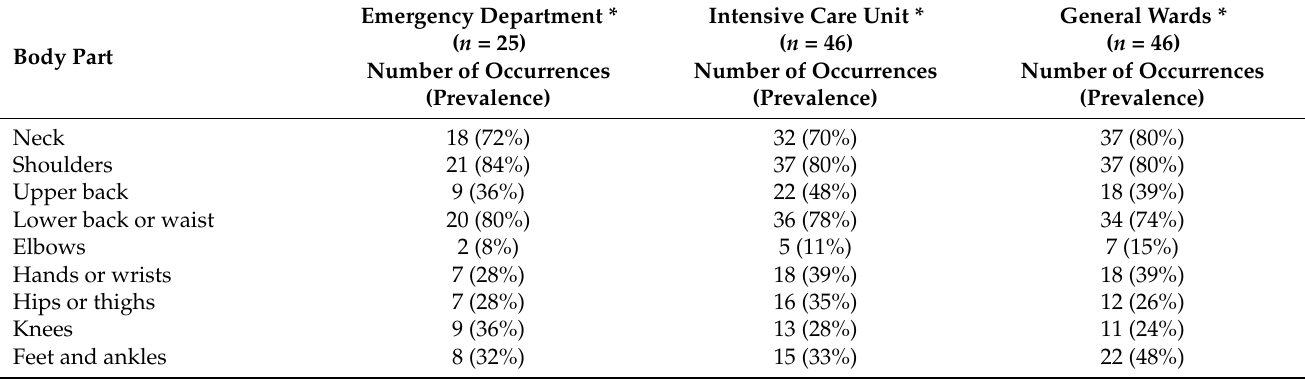
Table 2. Musculoskeletal disorder (MSD) prevalence for each body part in the past year.